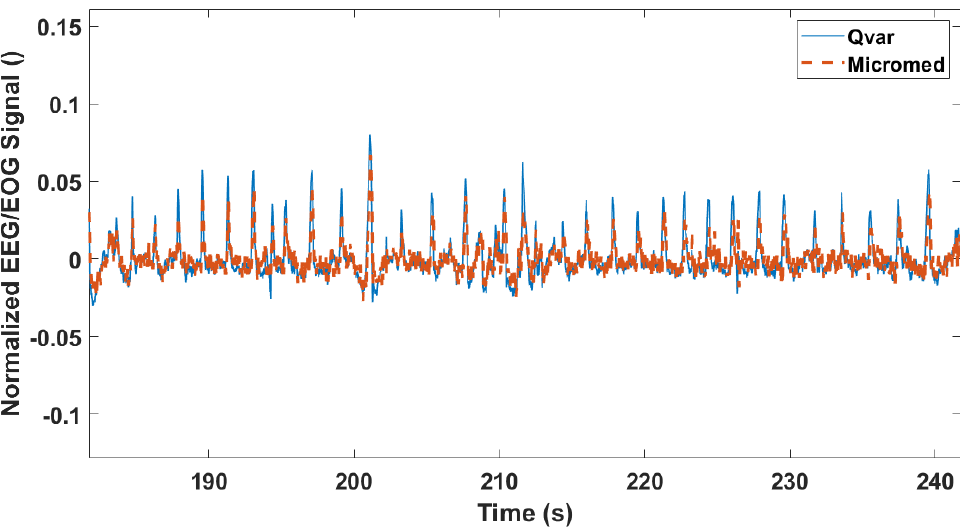
Figure 18. EOG trace recorded from ST−Qvar and the gold standard during eye blinking test. Each peak represents an eye blink.